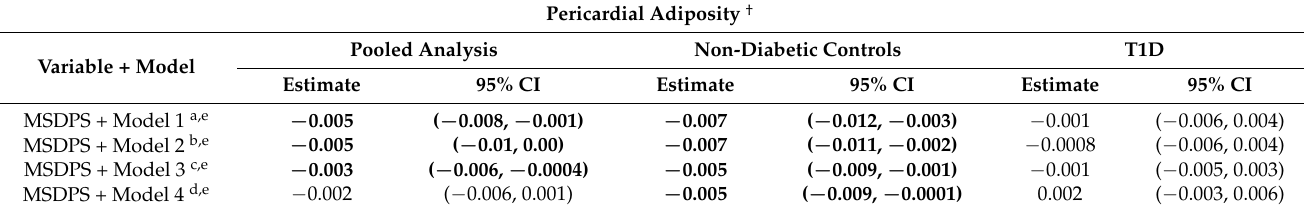
Table 3. Baseline associations of Mediterranean-Style Dietary Pattern Score with the volume of Pericardial